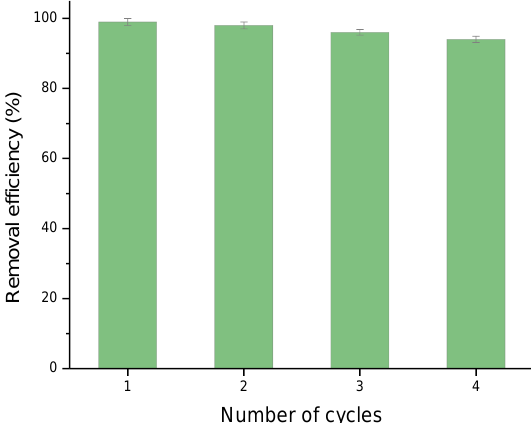
Figure 14. CXTi reusability after testing against degradation of MB dye (C 0 = 100 mg L −1 , T = 23 °C, dose = 0.01 g mL −1 , total treatment time 120 min).